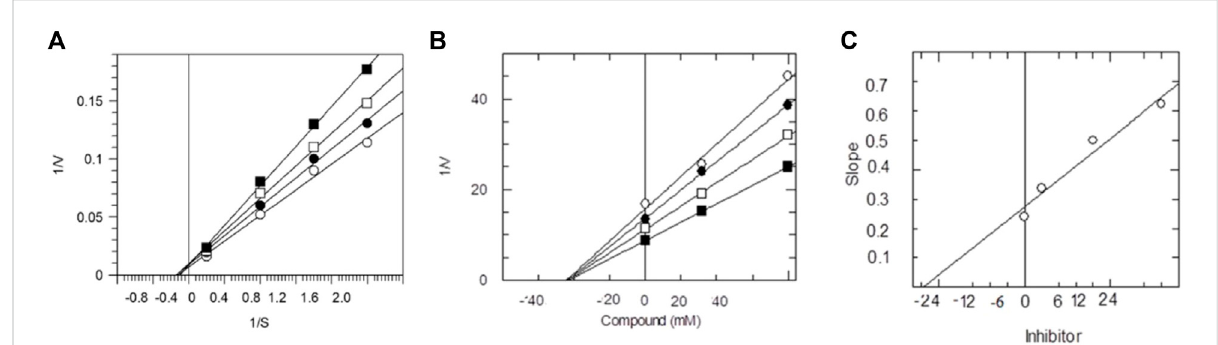
FIGURE 2 The inhibition of AChE by compound 9 , (A) is the reciprocal plot (Linewear-Burk) between initial velocities and four fi xed ACh conc. in the absence ( ■ ) and presence of 100 µm ( □ ), 150 µM ( C ), 175 µM ( ○ ) of compound 9 . (B) Dixon plot of reciprocal between initial velocities and